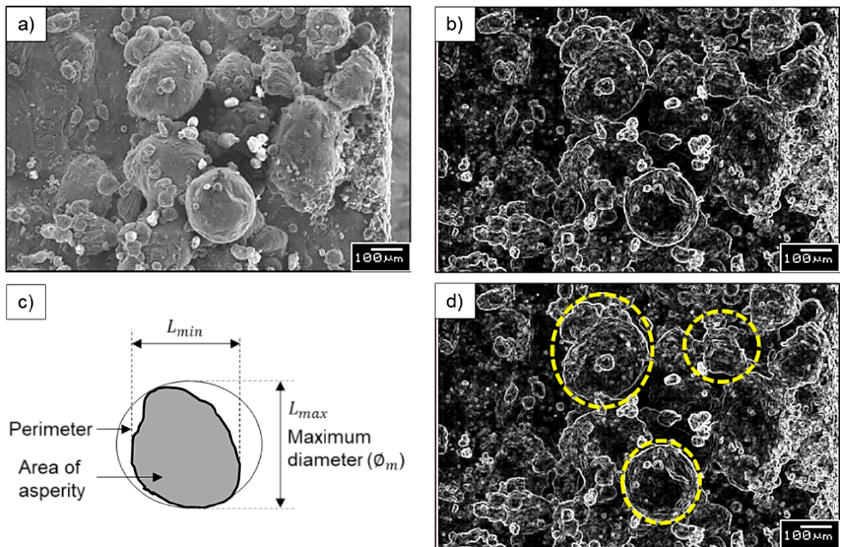
Figure 4. Image processing steps to determine the maximum diameter of asperities. ( a ) raw SEM image; ( b ) post-processing to determine the edges; ( c ) definition of maximum diameter; and ( d ) measuring the maximum diameter of asperities.